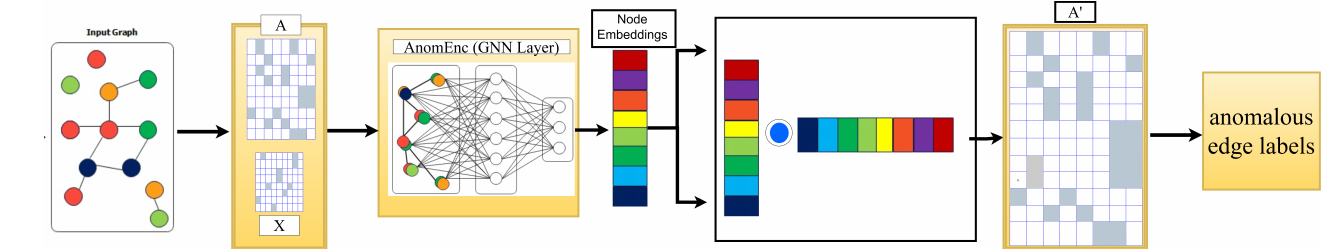
Figure 2. The Proposed Framework (EdgeAnomEn) for Edge Anomaly Detection in Attributed Networks. Network